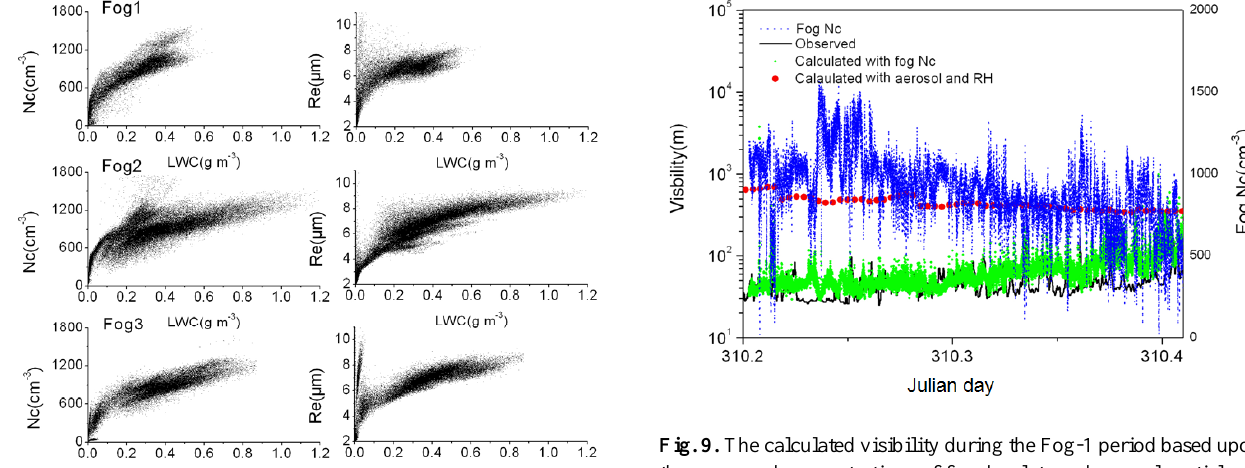
Fig. 9. The calculated visibility during the Fog-1 period based upon the measured concentrations of fog droplets and aerosol